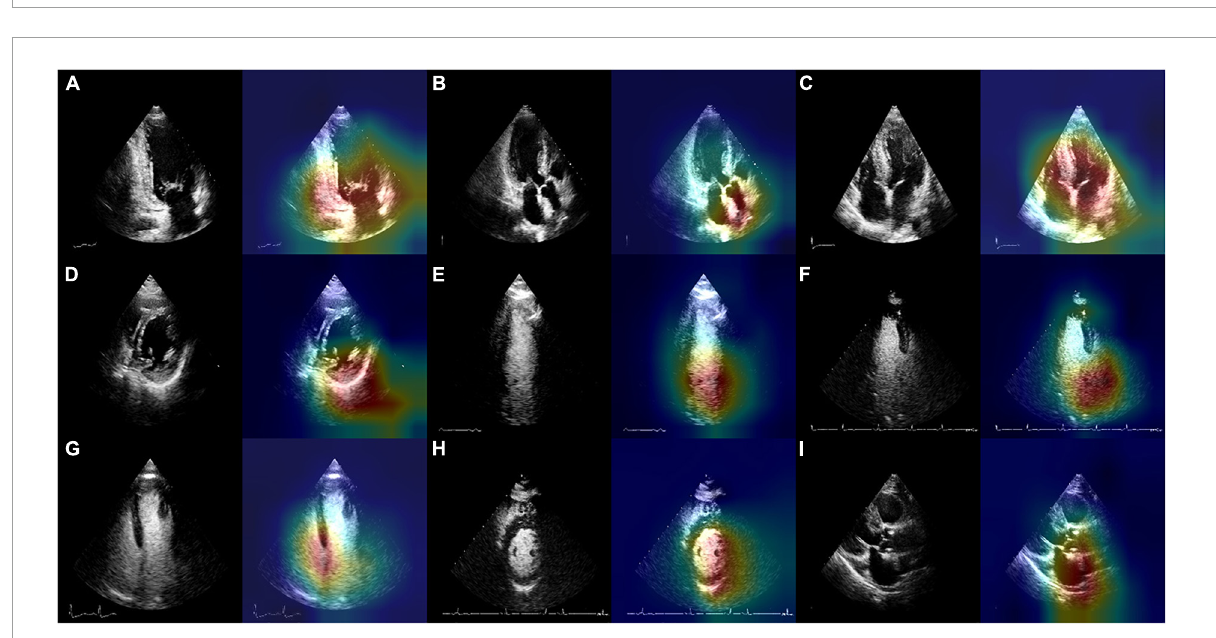
FIGURE5 Original images and the results of EchoV-Net visualization of the most related regions for view recognition. (A) 2DE.A2C, (B) 2DE.A3C, (C) 2DE.A4C, (D) 2DE.PSAX, (E) C2DE.A2C, (F) C2DE.A3C, (G) C2DE.A4C, (H) C2DE.PSAX, and (I) Other. 2DE, two-dimensional echocardiography; C2DE, contrast two-dimensional echocardiography; A2C, apical 2-chamber; A3C, apical 3-chamber; A4C, apical 4-chamber; PSAX, parasternal left ventricular short axis; Other, including parasternal left ventricular long axis, pulmonary artery long axis, and major artery short